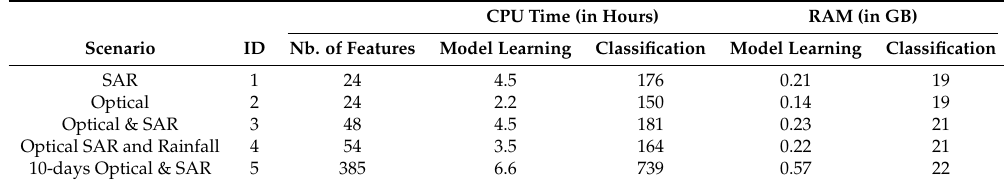
Table 6. Computational resources for the learning and classification stages, for each